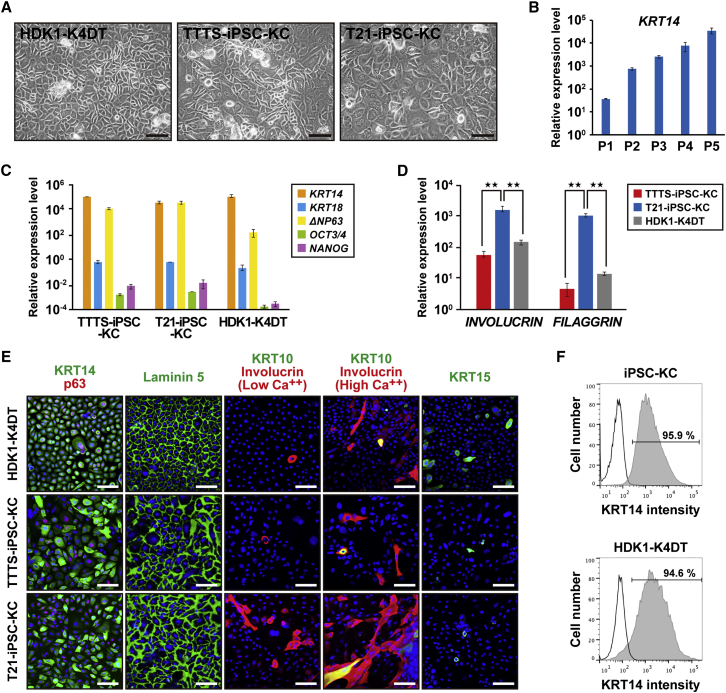
Characterization of a Homogeneous Population of Keratinocytes Derived from Induced Pluripotent Stem Cells(A) Phase-contrast microscopic analysis of human dermal keratinocytes (HDK1-K4DT) and keratinocytes derived from AF-T21-iPSCs (T21-iPSC-KC) and AF-TTTS-iPSCs (TTTS-iPSC-KC). Both iPSC-derived keratinocytes showed human keratinocyte-like morphology. Image of “T21-iPSC-KC” is identical to “iPSC-KC at passage 3–4” in Figure S3B. Scale bars, 500 μm.(B) Real-time qPCR analysis of KRT14 at each passage. Values are shown as means ± SD from three independent experiments.(C) Real-time qPCR analysis of epithelial markers, i.e., KRT14, KRT18, and ΔNP63, and stem cell markers, i.e., OCT3/4 and NANOG, in human iPSC-KCs at passage 4. The epithelial marker expression levels in iPSC-KCs were similar to those of HDK1-K4DT. The expression levels of each gene in the parental iPSCs were regarded as equal to 1 (100). Values are shown as means ± SD from three independent experiments.(D) Real-time qPCR analysis of terminal differentiation markers, i.e., INVOLUCRIN and FILAGGRIN. T21-iPSC-KCs showed higher expression levels of INVOLUCRIN and FILAGGRIN than did TTTS-iPSC-KCs. The expression levels of each gene in the parental iPSCs were regarded as equal to 1 (100). Values are shown as means ± SD from three independent experiments. ∗∗p < 0.01.(E) Immunofluorescence of epithelial markers, i.e., KRT14, p63, laminin 5, involucrin, KRT10, and KRT15. Under the high-calcium condition, iPSC-KCs expressed involucrin and KRT10 at a higher frequency, indicating accelerated epidermal differentiation. Scale bars, 100 μm.(F) Flow-cytometric analysis of KRT14 in iPSC-KCs at passage 2. Isotype controls are included in each panel.See also Figures S3 and S4.